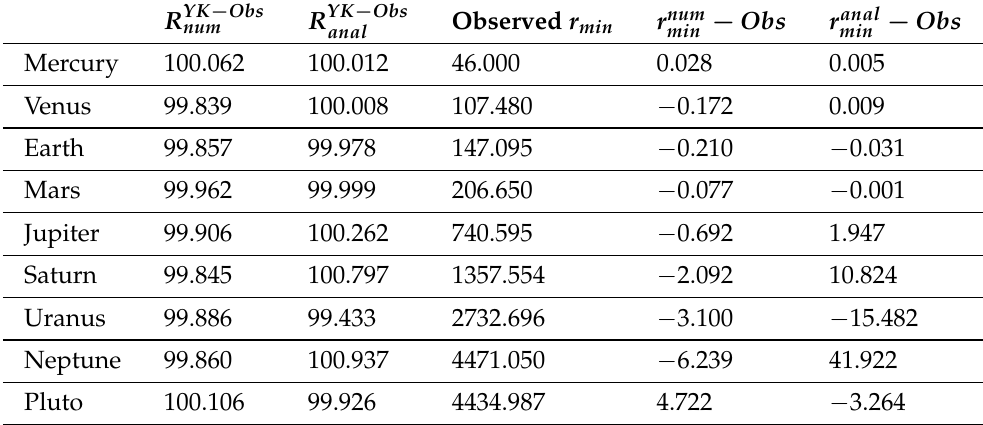
Table A20. Absolute deviation of r min from observation with nominal α , evaluated in (10 6 km).